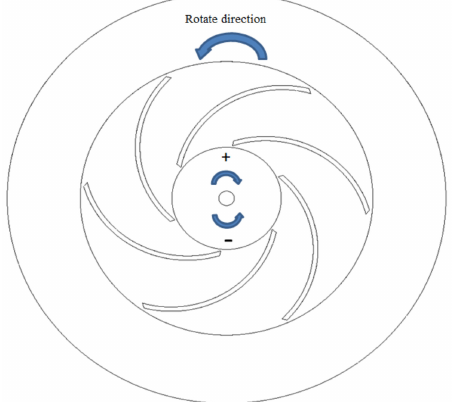
Figure 2. Definition of the direction of pre-swirl inflow. The clockwise and counterclockwise directions are termed as counter − rotating and co − rotating inflows,